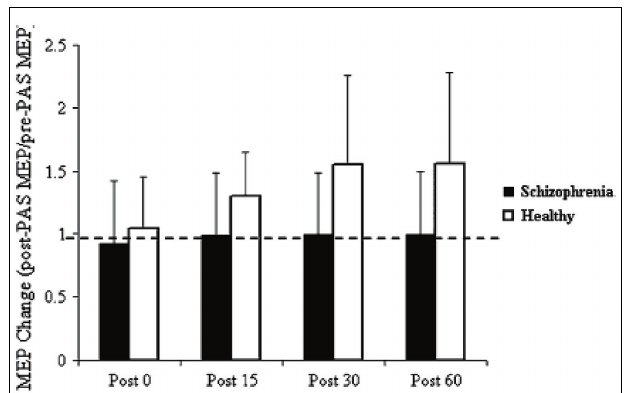
FIGURE 1 | Effect of PAS on MEP amplitude. Values represent a ratio of post-/pre-MEP amplitude.Values greater than 1 (dashed line) represent a PAS-induced MEP facilitation. Results demonstrate that patients with SCZ demonstrated no MEP facilitation (Frantseva etal., 2008).